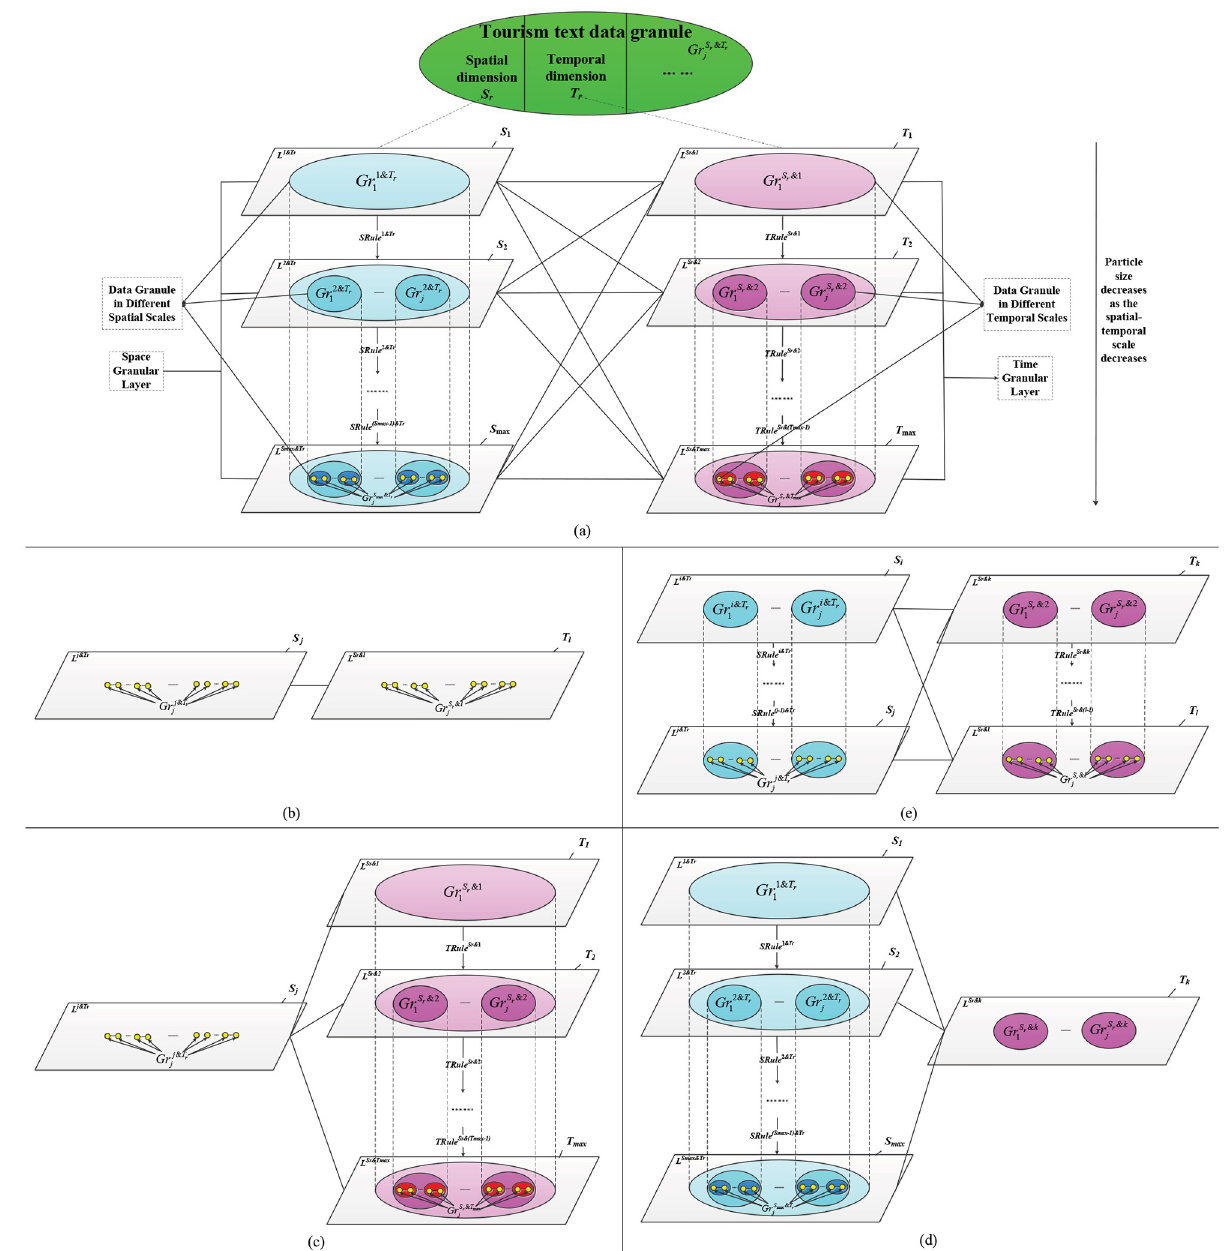
Fig 1. Schematic diagram of the tourism text data granular structure at multi-spatiotemporal scales. (a) granular structure of tourism text data; (b) popularity mining of single spatial scale data granules at a single temporal scale; (c) popularity mining of single spatial scale data granules at multi- temporal scales; (d) popularity mining of multi-spatial scale data granules at a single temporal scale; (e) popularity mining of multi-spatial scale data granules at a multi-temporal scale.